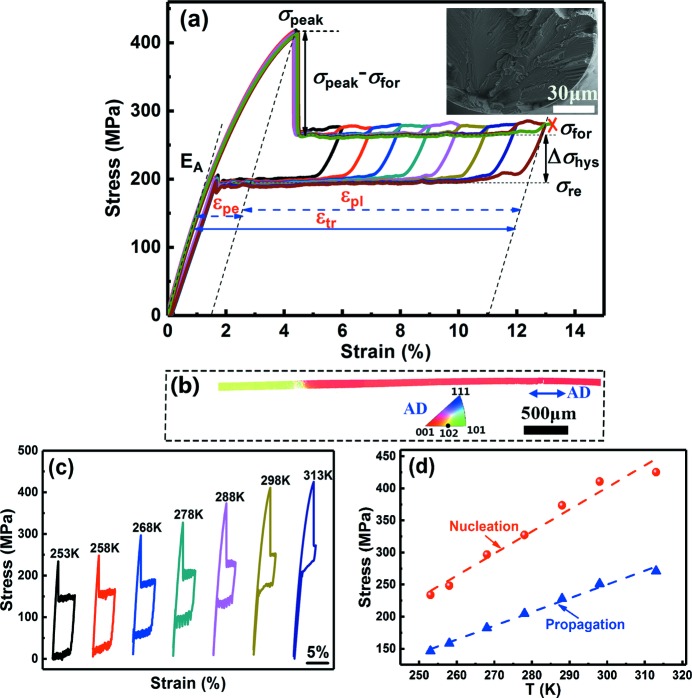
(a) Tensile stress–strain curves of the Ni43.7Cu1.5Co5.1Mn36.7In13 microwire, measured up to different strain levels at room temperature. The symbol (×) represents the point of fracture. The upper right inset shows a fractograph after the tensile test. (b) An EBSD orientation map of the tested microwire. This map is presented in inverse pole-figure mode; the legend (parallel to AD) is also displayed in the figure. AD denotes the axial direction of the microwire. (c) Tensile stress–strain curves measured at different temperatures from 253 to 313 K. (d) The temperature dependence of the nucleation stress and propagation stress.